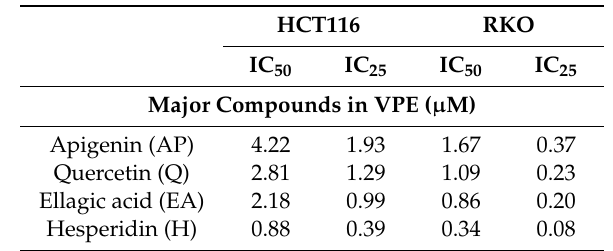
Table 3. Major constituents as present in the IC 50 and IC 25 concentrations of the VPE extract in HCT116 and RKO cells (expressed in µ M).